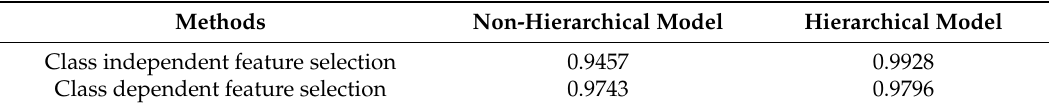
Table 11. Classification accuracy comparison of the PAMAP2